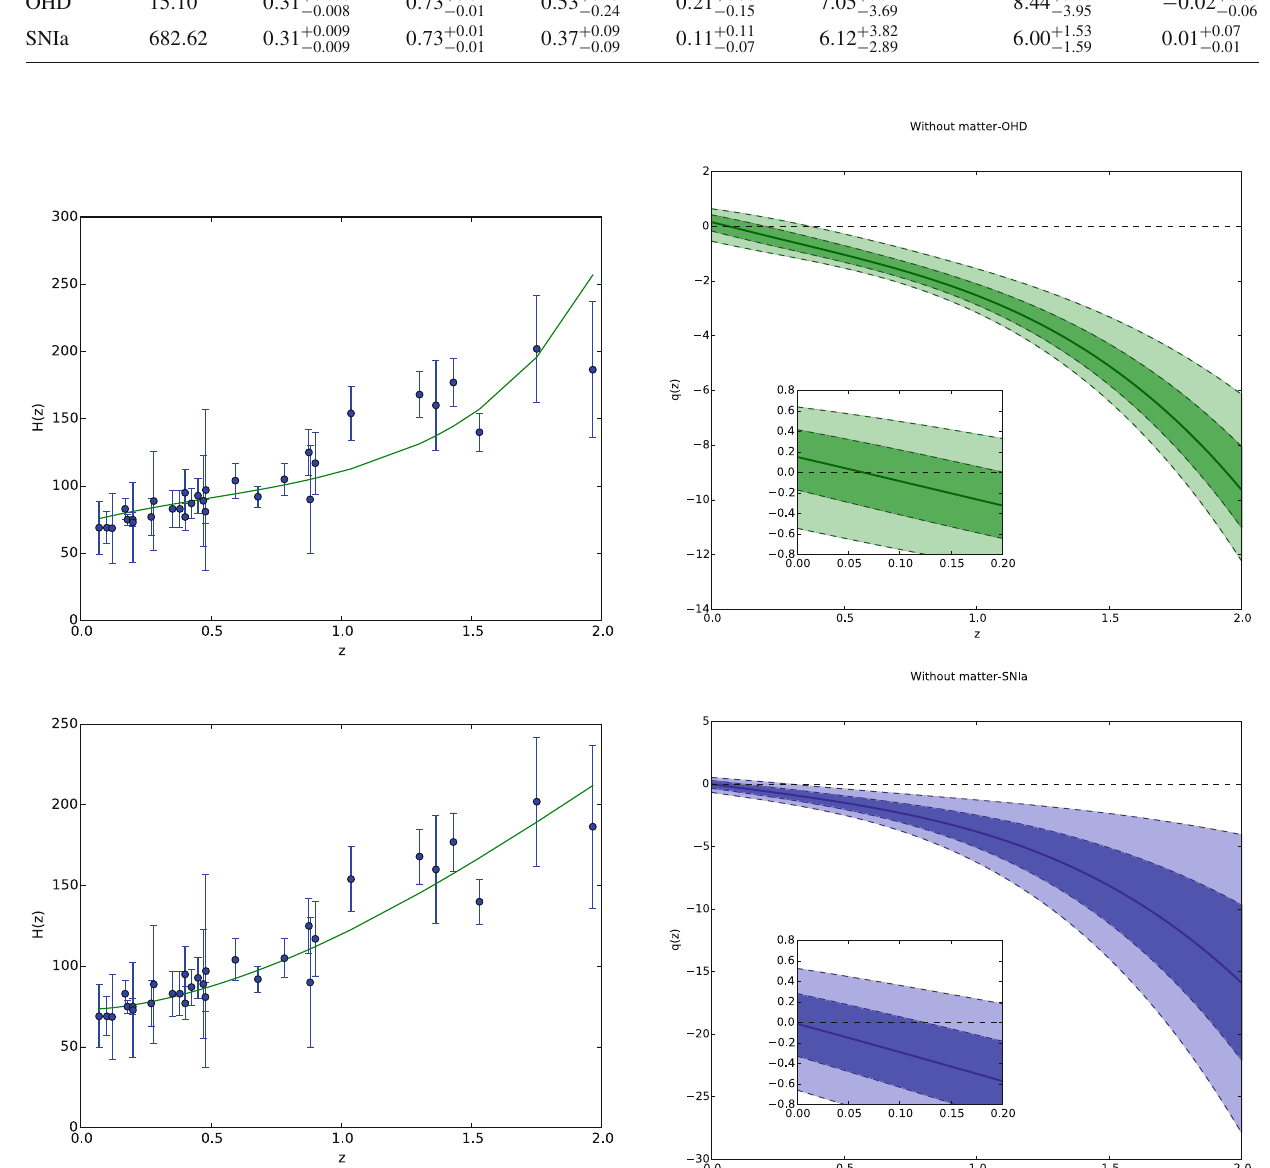
Fig. 12 Fitting to OHD data (blue dots) using the mean values of the NED parameters into the theoretical H ( z ) (solid line) for the case with- out matter (Eq. 62, top panel) and including matter (Eq. 90, bottom panel)